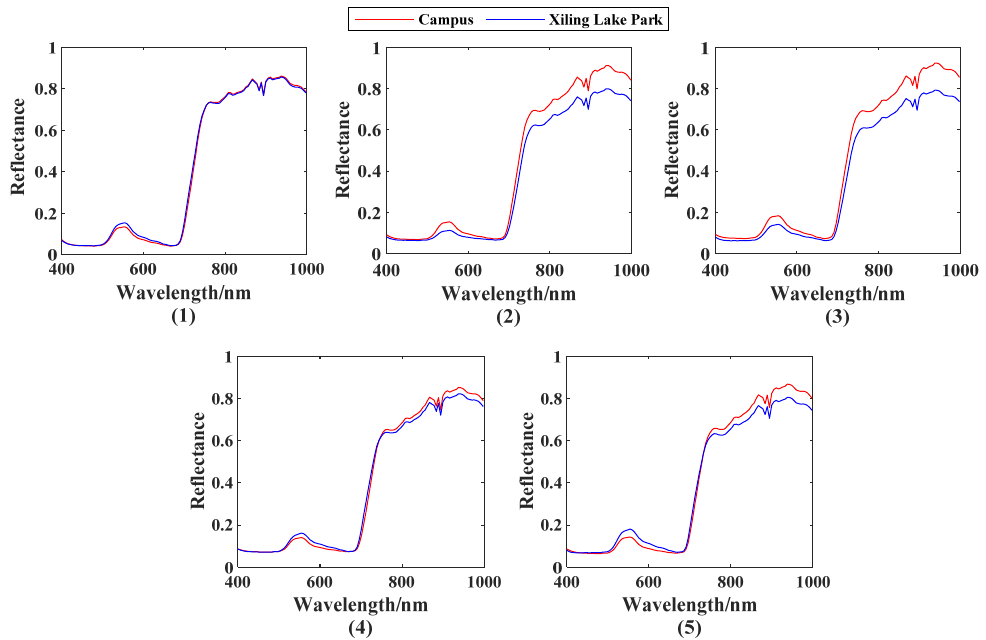
Figure 10. Average reflectance spectra of leaves for each tree species in different regions. ( 1 ) Ilex chinensis Sims , ( 2 ) Lonicera maackii , ( 3 ) Sophora japonica , ( 4 ) Amygdalus triloba , and ( 5 ) Syringa oblata Lindl.